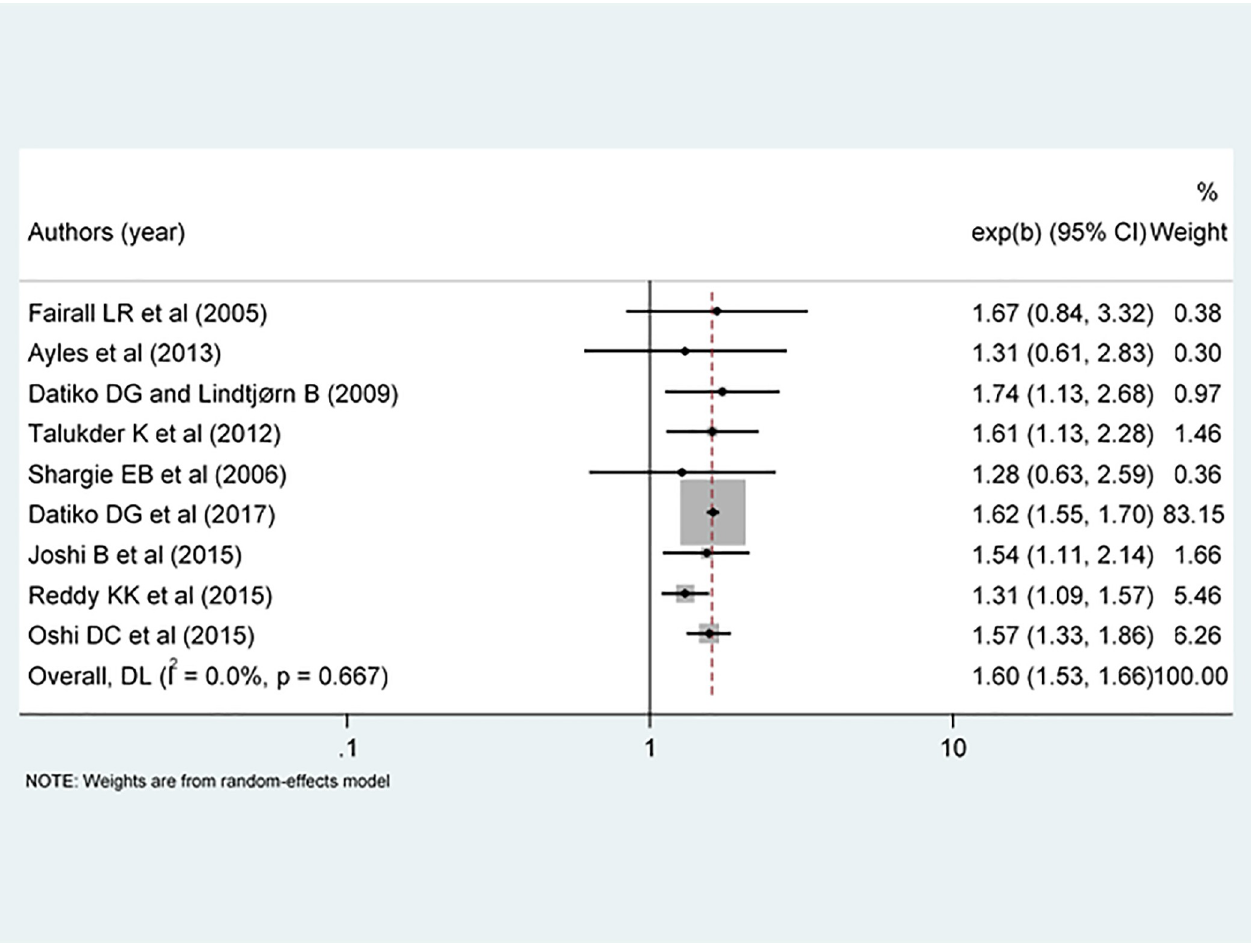
Fig 2. Forest plot of the effect size of training on tuberculosis case detection in TB high burden